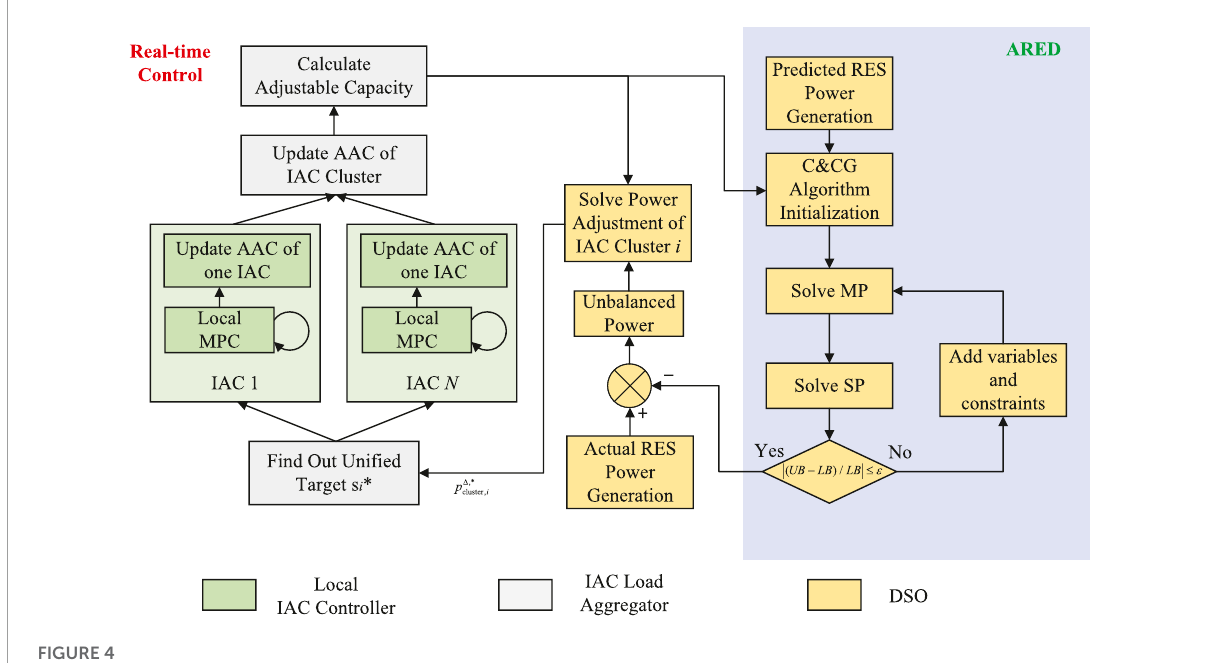
FIGURE 4 Schematic of ARED and real-time control processes.